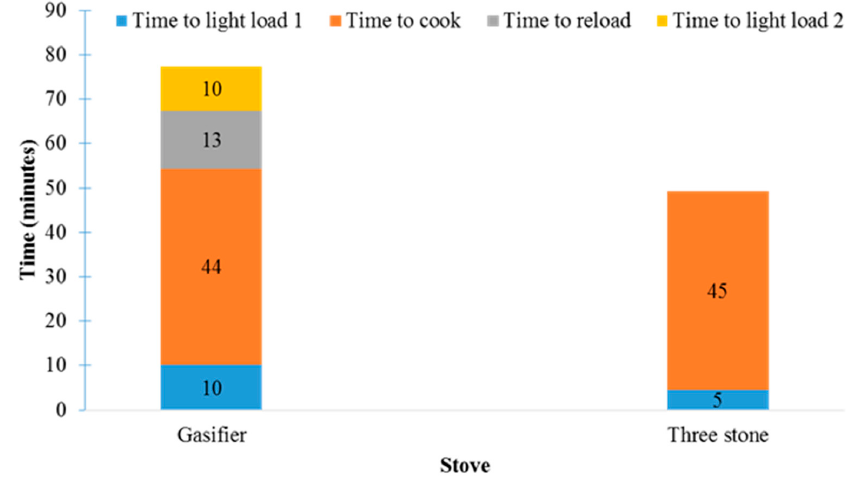
Figure 4. Time spent in cooking with the gasifier and three-stone open fire.